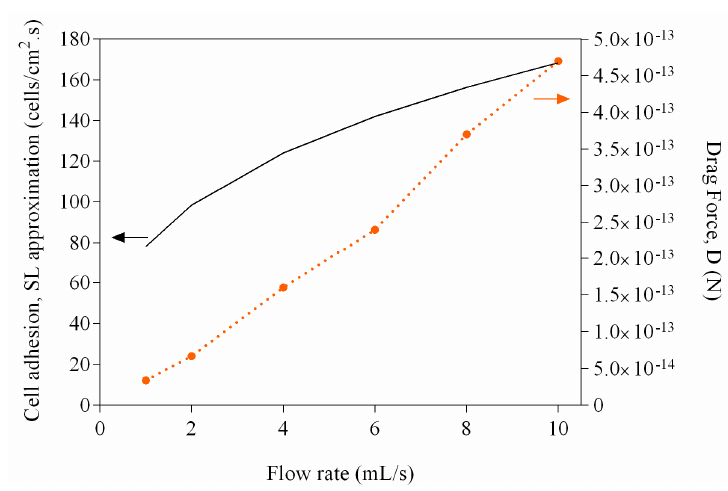
Figure 5. Variation of the drag force (D) and values obtained with the Smoluchowski-Levich (SL) approximation as a function of the flow rate (1 to 10 mL / s). The full line represents the predicted adhesion rate using the SL approximation and the dashed line represents the drag force.